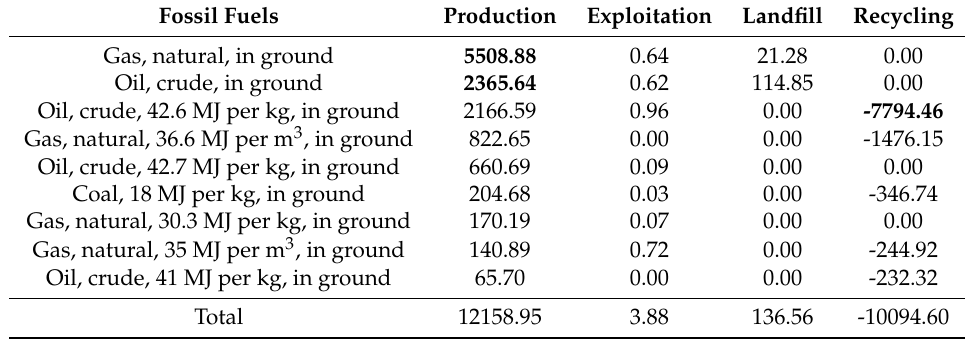
Table 14. Results of grouping and weighting of after-e ff ects of environmental processes related to the extraction of fossil fuels, occurring in the 1 megawatt photovoltaic power plant [unit: